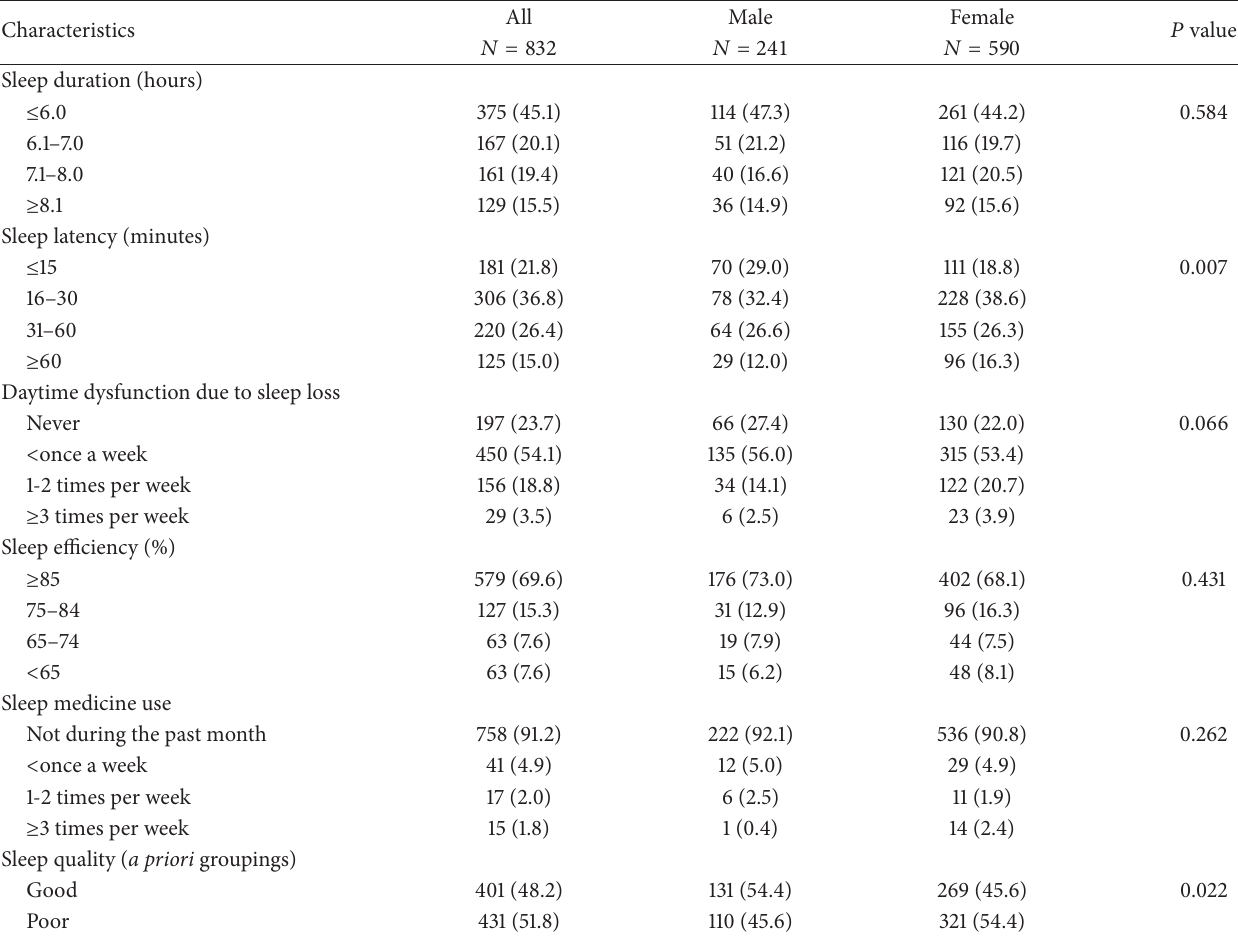
Table 2: PSQI sleep quality patterns by sex.